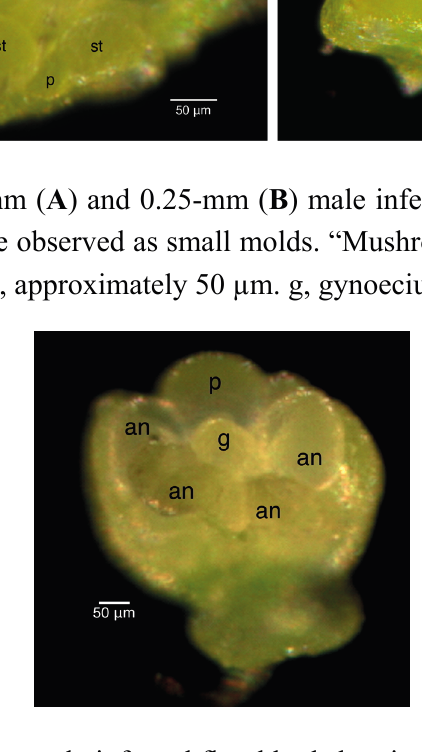
Figure 3. Stage 7 of 0.3 mm male infected floral bud showing bilobal external anthers and petals like small molds. Size bars, approximately 50 µm. g, gynoecium; an, anther; p, petal.